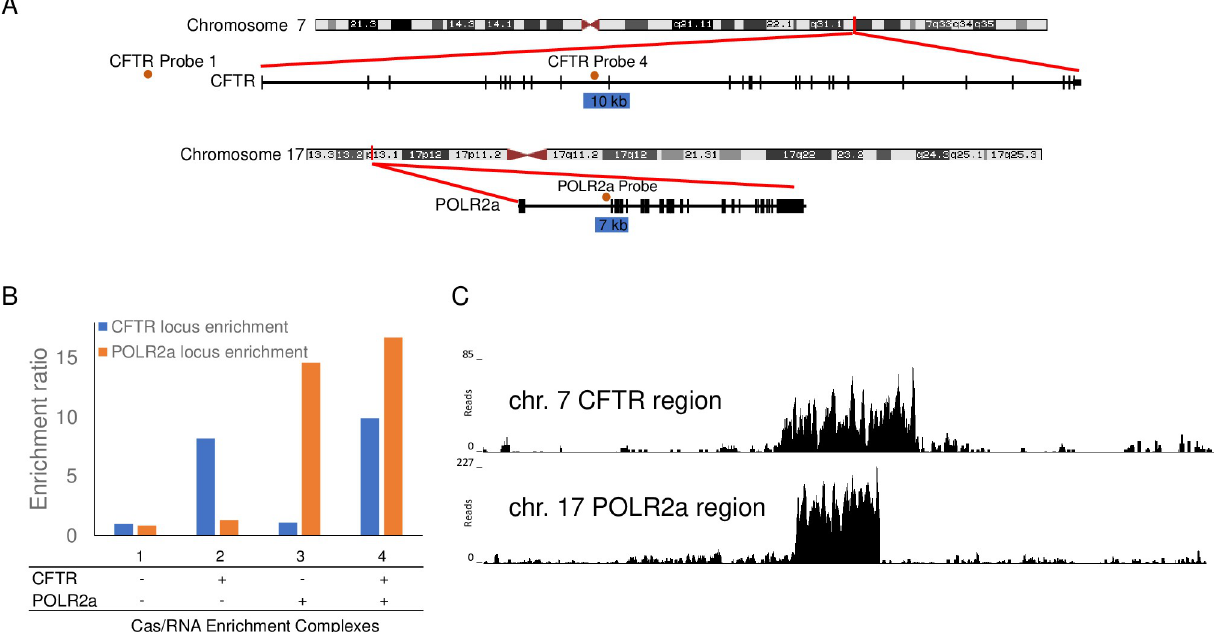
Fig 6. Targets for Cas9/sgRNA multiplexing protection experiments. (A) Diagram showing the position of two Cas9/sgRNA complexes within the CFTR gene on human chromosome 7, two Cas9/sgRNA complexes within the POLR2a gene on human chromosome 17, and the location of the qPCR probes used in the analyses. (B) qPCR analyses demonstrating multiplexing Cas9/sgRNA protection of human genomic targets. Ratios of on target and off target results for exonuclease treated and non-exonuclease treated samples. Sample 1, no protection; Sample 2, CFTR protection; Sample 3, POLR2a protection; Sample 4, average of four independently performed CFTR/POLR2a multiplex protection reactions. (C) NGS reads mapping to two regions from an NGS library prepared from Cas9/sgRNA and exonuclease treated human genomic DNA for both CFTR 10 kb protection and POLR2a 7 kb